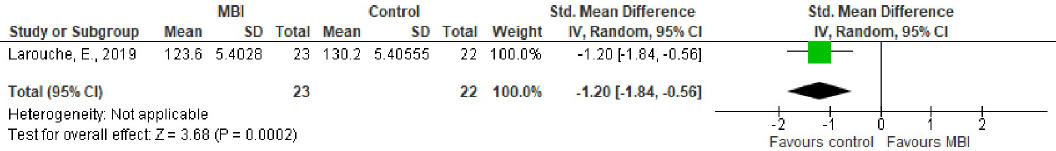
Fig 11. Forest plot of comparison: Mindfulness, MBI versus control after 6 to 10 weeks from the beginning of the intervention.